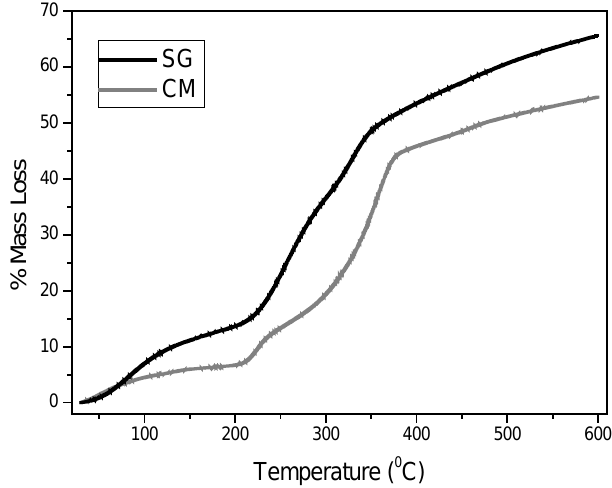
Figure 4. Thermogravimetric analysis of both adsorbents under nitrogen atmosphere at a heating rate of 5 °C/min.